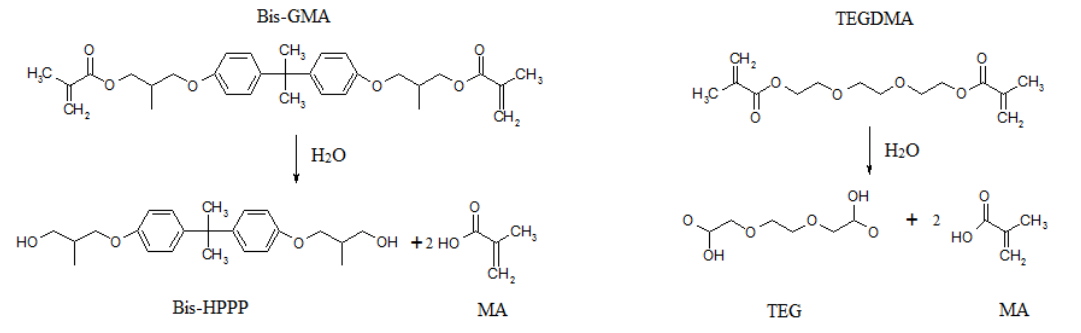
Figure 2. Mechanism of hydrolysis processes of BisGMA and TEGDMA.